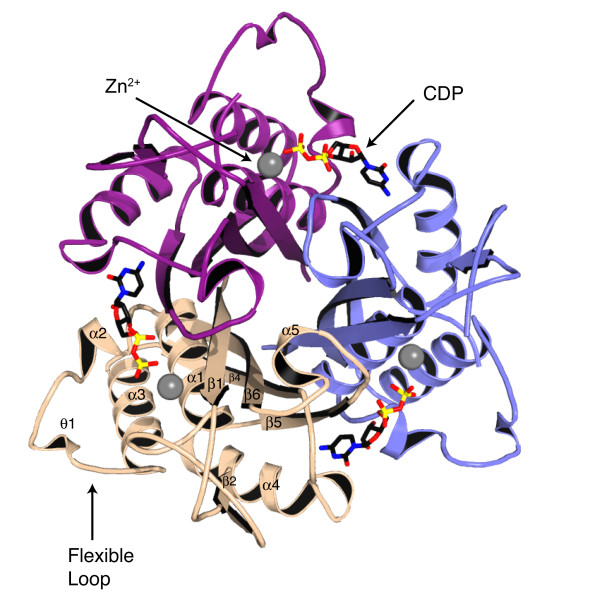
Ribbon diagram of the trimer. The MsIspF trimer viewed down the molecular three-fold axis. The individual subunits are shown in slate, wheat, and purple. Selected secondary structure elements of the wheat subunit, CDP and Zn2+ are depicted as in Figure 5.